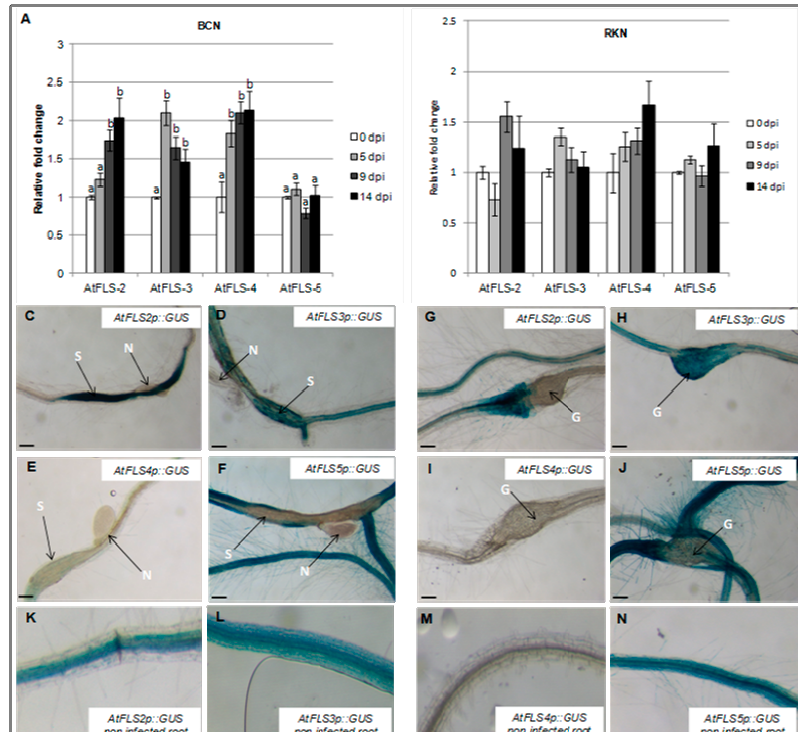
Figure 4. Temporal expression of Arabidopsis FLS gene family members during nematode infection. Expression of AtFLS2 , AtFLS3 , AtFLS4 , and AtFLS5 was quantified by qRT-PCR in roots of wild-type Arabidopsis plants at 0, 5, 9 and 14 dpi with the sugar beet cyst nematode, H. schachtii ( A ) of the southern root-knot nematode, M. incognita ( B ). Histochemical localization of GUS activity directed by AtFLSp::GUS in H. schachtii -induced syncytia ( C – F ) and in M. incognita -formed galls ( G – J ) at 9 dpi. ( K – N ) are non-infected Arabidopsis roots; G, galls; N, nematode; S, syncytium; R, Arabidopsis root. Expression was normalized to the Arabidopsis Actin8 gene and presented relative to expression at 0 dpi. Values are means ± SE ( n = 3 technical replicates) with di ff erent letters indicating significant di ff erences between time points p < 0.05 (One-way ANOVA test). Similar results were obtained from a second, independent biological replicate. Scale bar = 200 µ m ( C , J , N ), and 150 µ m ( K – M ).